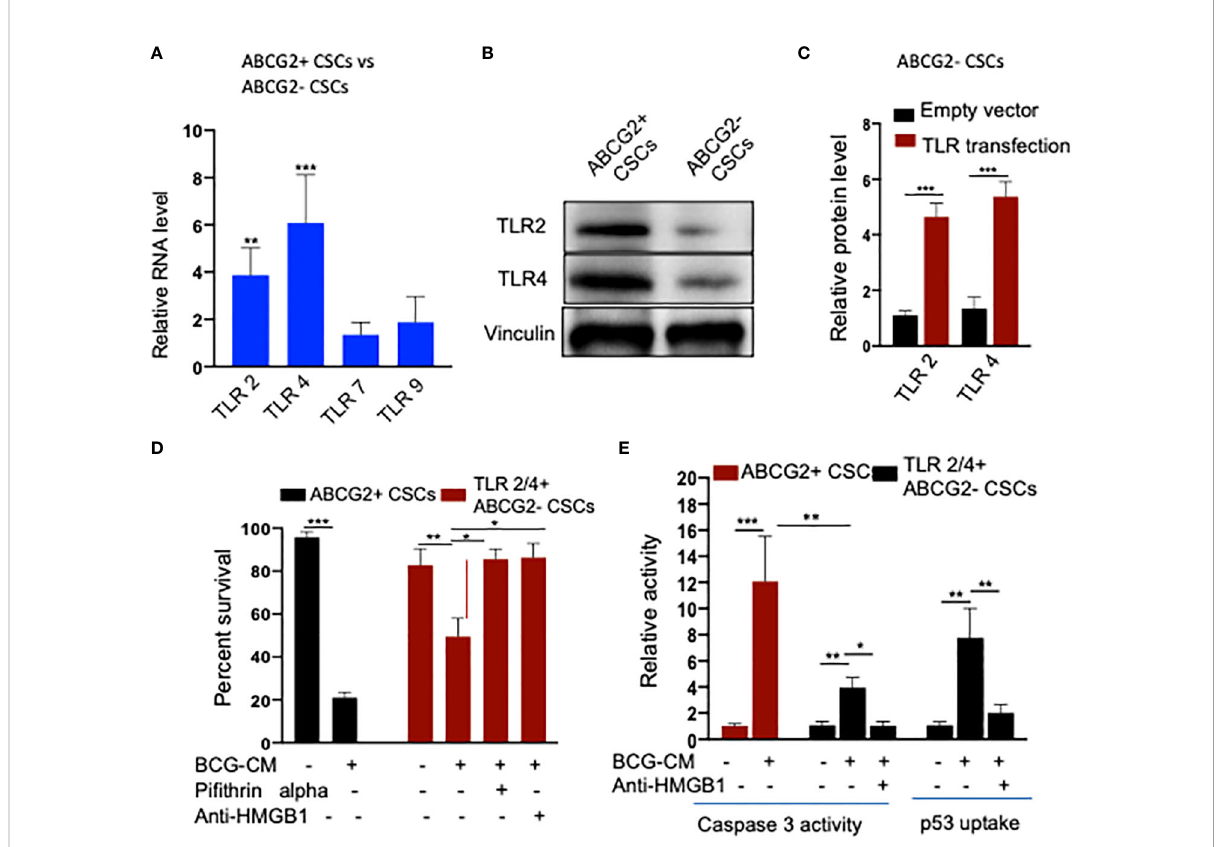
FIGURE 8 (A) TLR2 and TLR4 are required for the internalization of HMGB1/p53 complex into the CSCs. (B) Real-time PCR expression of TLR2, TLR4, TLR7, and TLR9 in EpCAM+/ABCG2+ CSCs vs. EpCAM+/ABCG2- CSCs. (C) Western blot shows TLR2/4 expression in EpCAM+/ABCG2+ CSCs vs. ABCG2 −